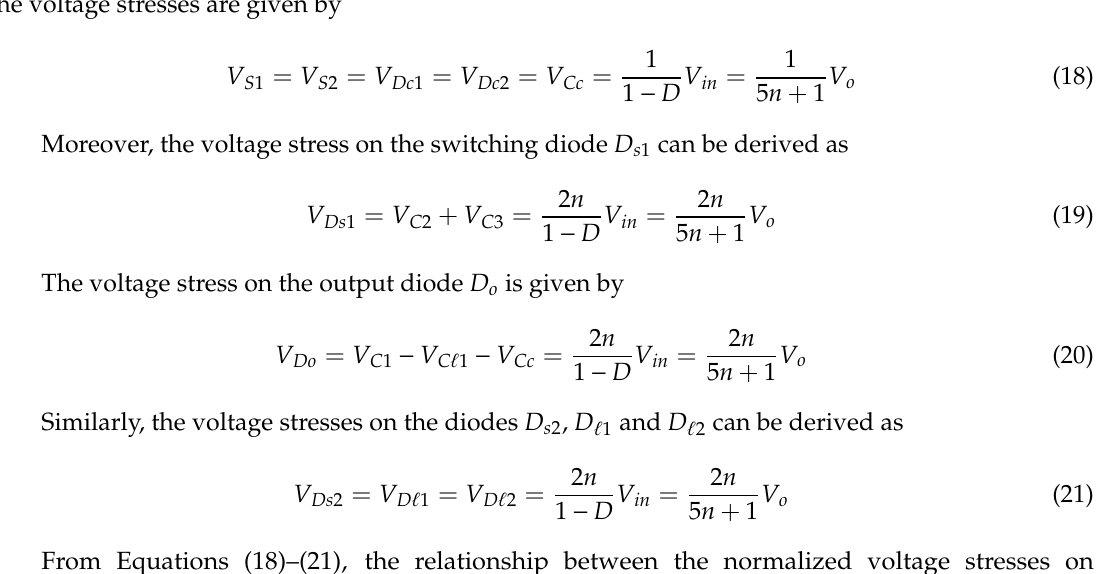
Figure 5. Voltage gain curve versus duty ratio with different turns ratio.